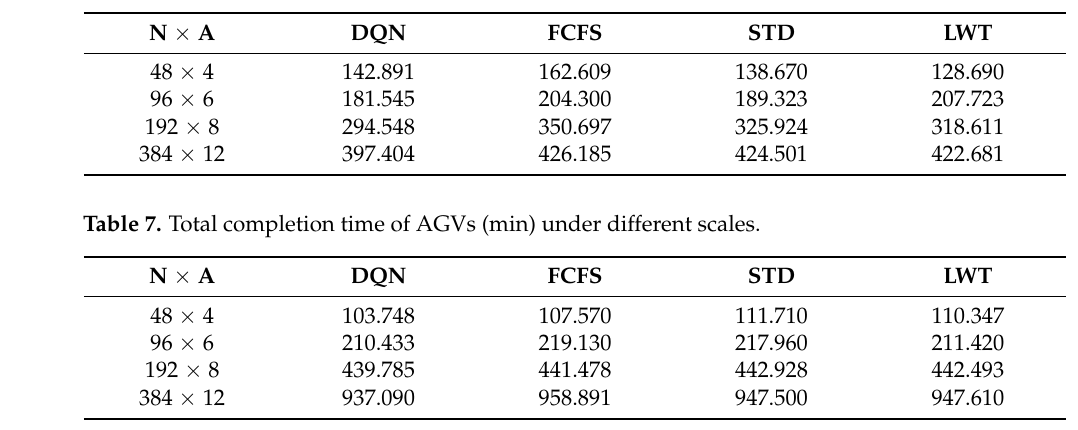
Table 6. Total waiting time of QCs (min) under different scales.